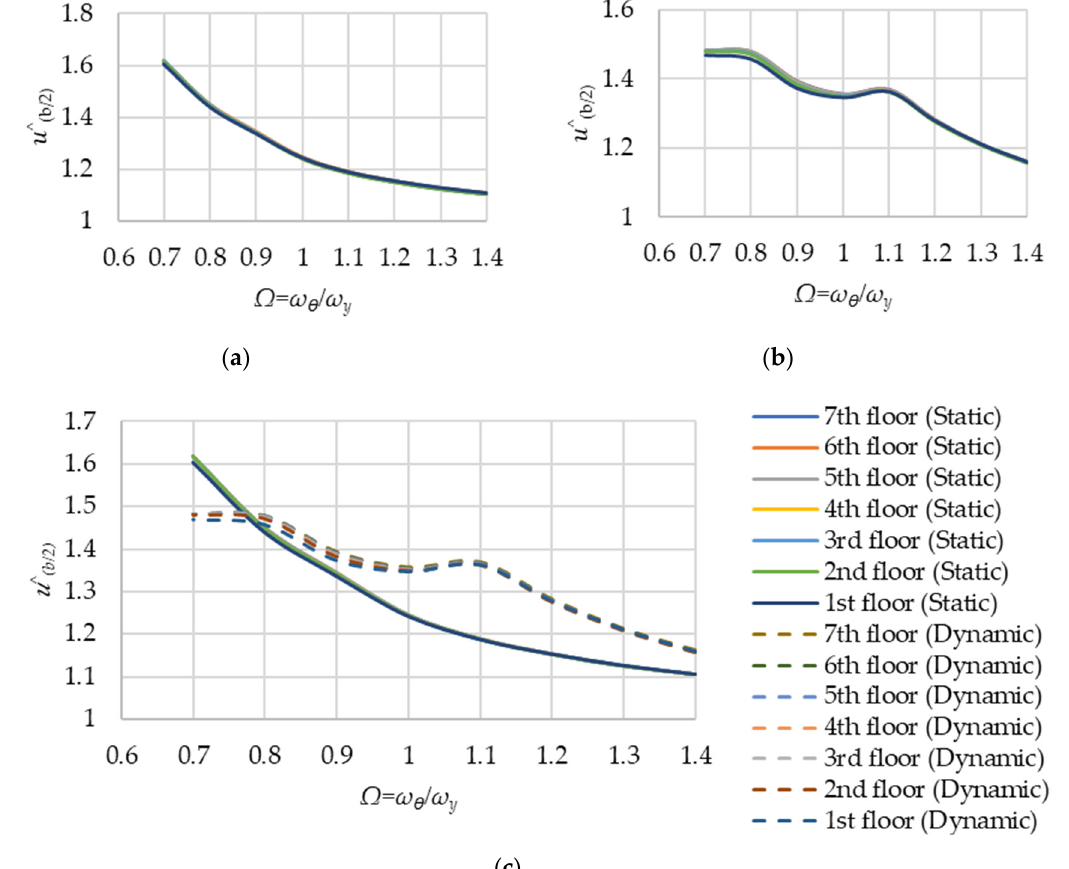
Figure 8. Normalized flexible edge displacement (with b / r = 1.4, Ty < 1 s): ( a ) Static edge displacement; ( b ) Dynamic edge displacement; ( c ) Static vs. dynamic edge displacement.